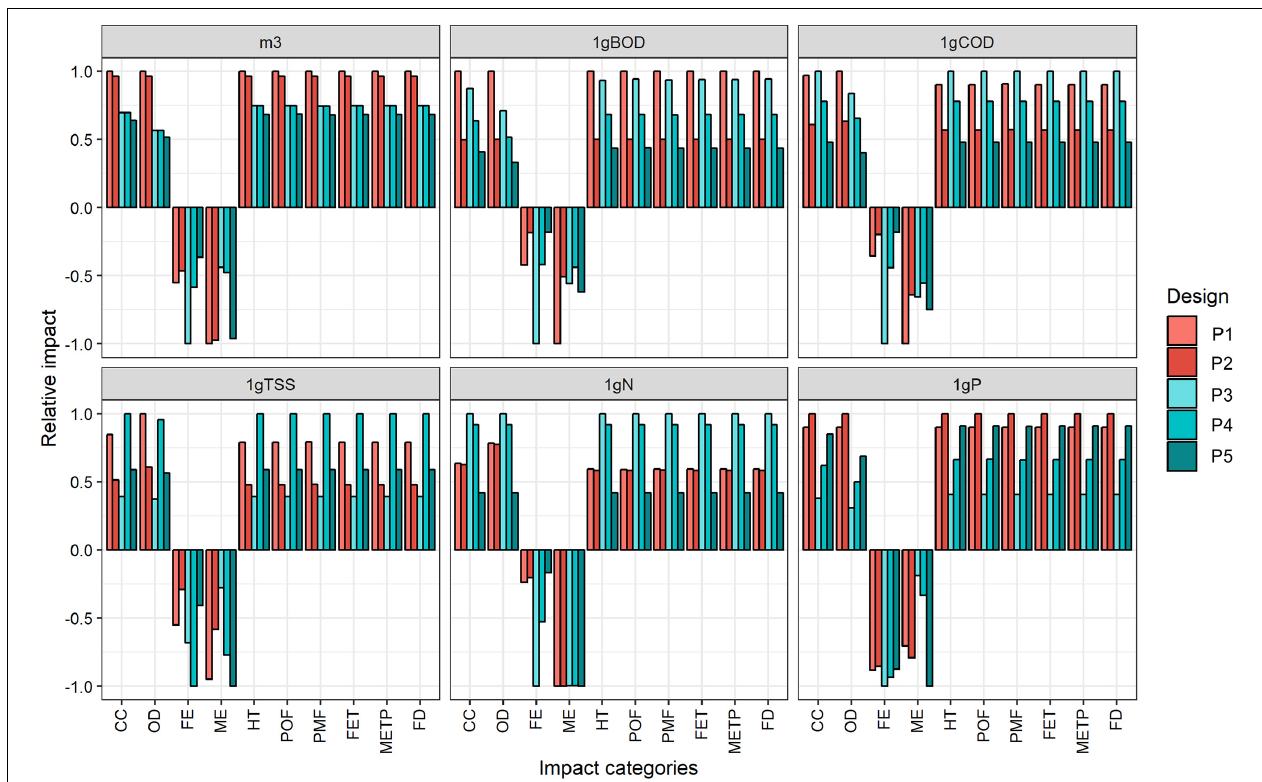
FIGURE 7 | Comparative analysis of relative results of METland R (cid:13) for several designs and periods.